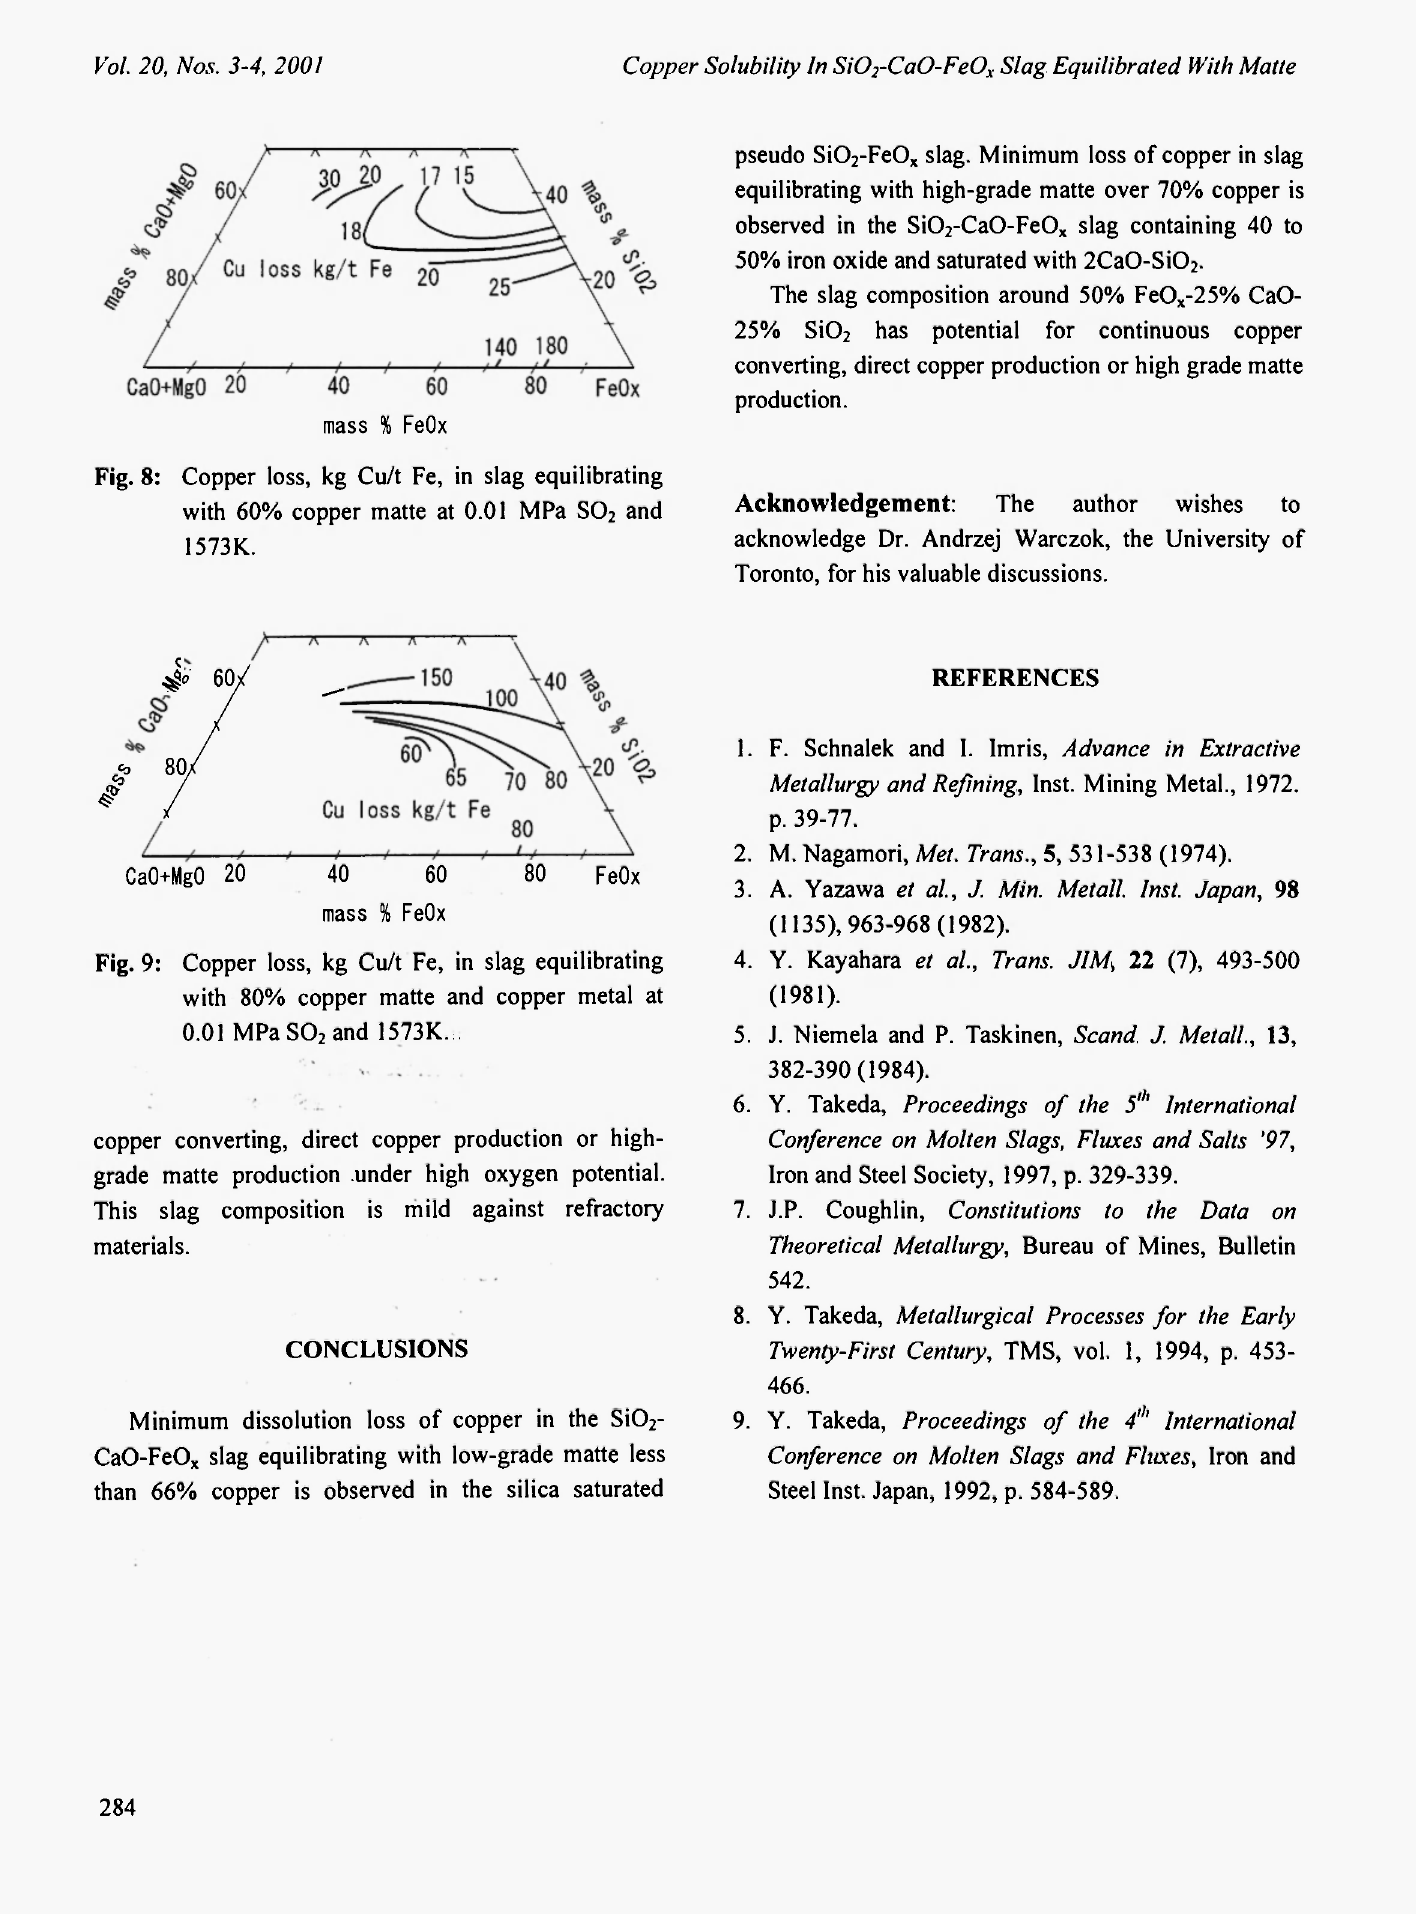
Fig. 9: Copper loss, kg Cu/t Fe, in slag equilibrating with 80% copper matte and copper metal at 0.01 MPa S0 2 and